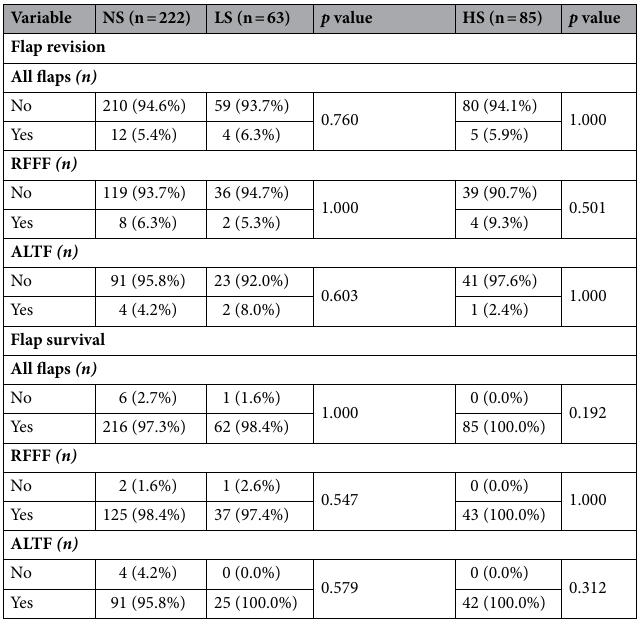
Table 2. Flap revision and survival. Parameters are indicated as numbers (with percentage) (separately described for the group of nonsmokers (NS), the group of light smokers (LS) and the group of heavy smokers (HS)); p values corresponding to testing for differences between groups (NS vs. LS and NS vs. HS) with Fisher’s exact test; NS nonsmokers, LH light smokers, HS heavy smokers, RFFF radial free forearm flap, ALTF anterolateral thigh